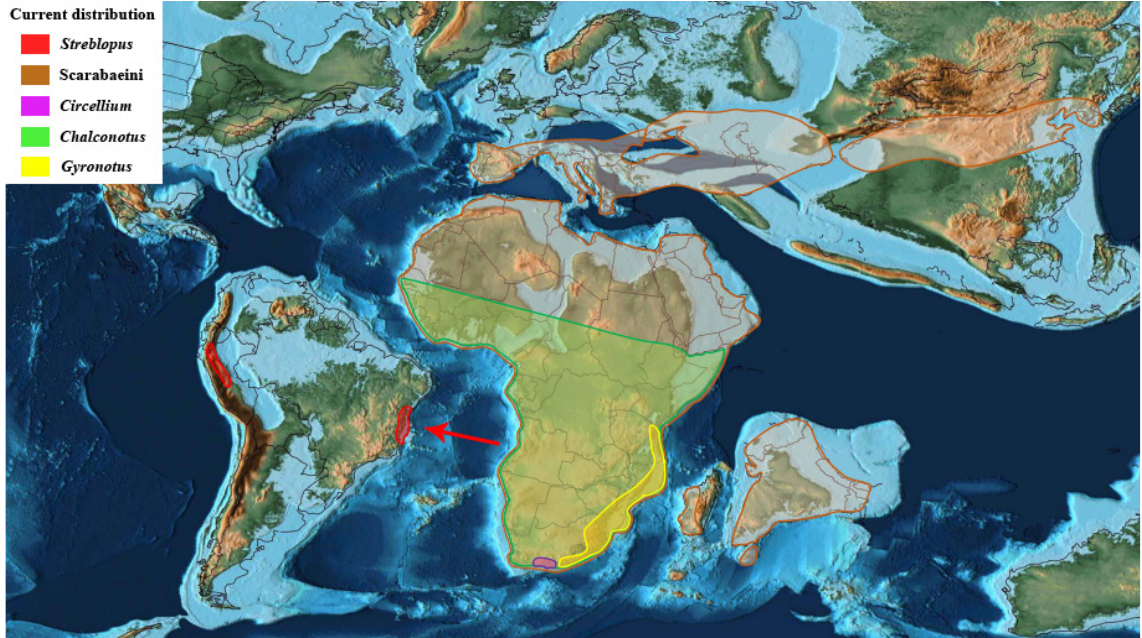
Fig. 29. Current distribution of Streblopus van Lansberge, 1874 and the Old World groups with which it is believed to be more closely related plotted on an Upper Cretaceous palaeomap (~ 80 million